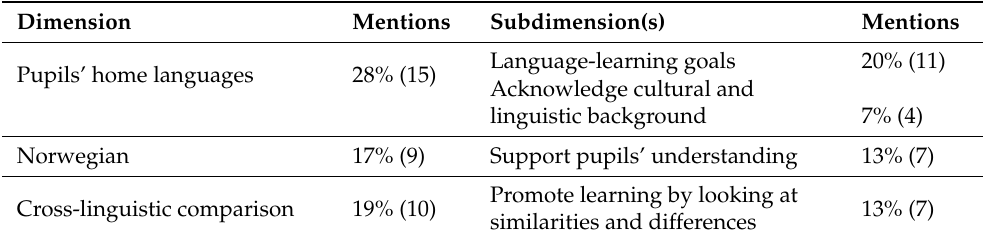
Table 10. Participant cognition about including other languages: main dimensions and subdimen- sion(s) in participants’ positive answers. Mentions are given as a percentage of the total number of participants, followed by the absolute number of mentions. More than one theme or subtheme can be present in a single participant’s